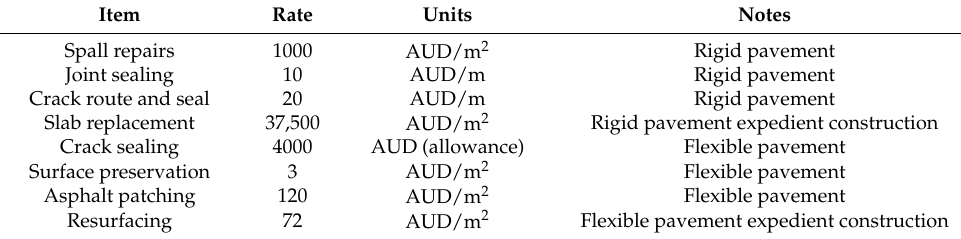
Table 7. Maintenance cost